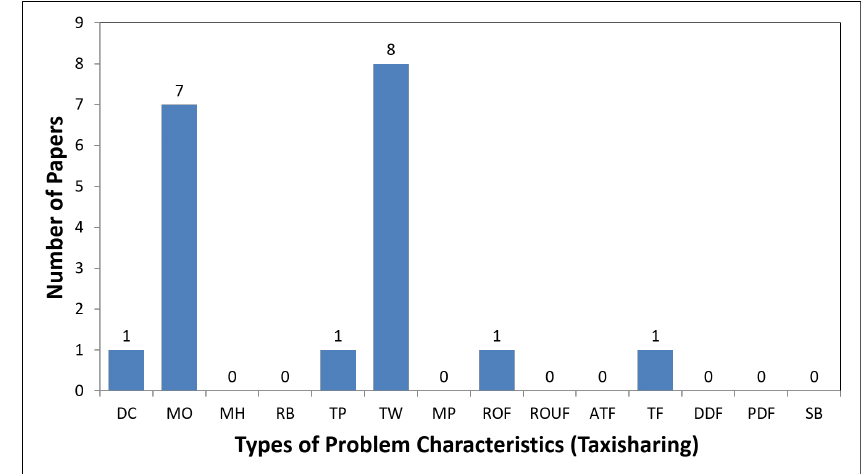
Figure 9. Distribution of Papers based on the Problem Characteristics: